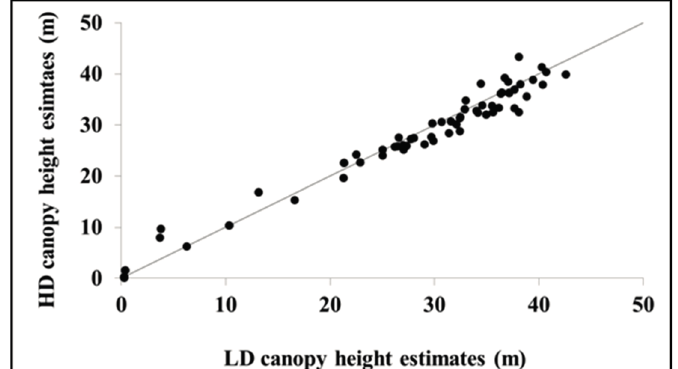
Figure 5. Comparison between canopy height estimates from the LD and HD